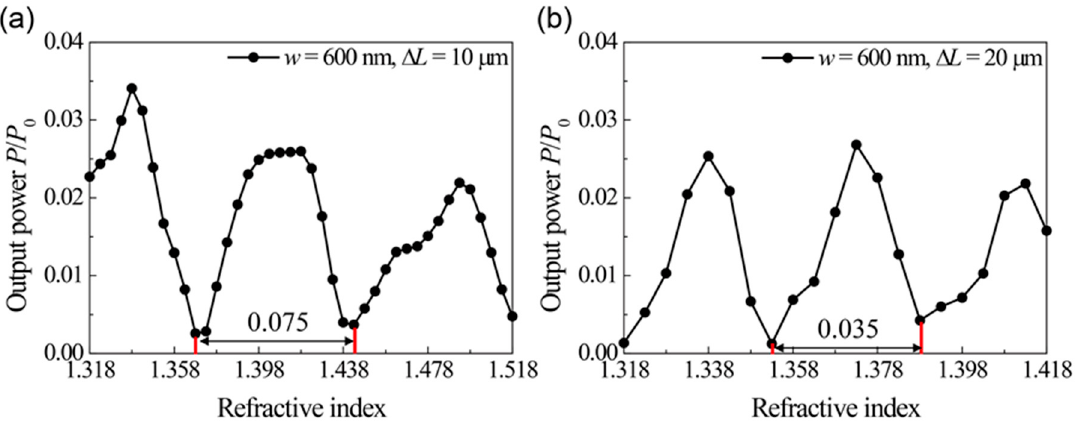
Figure 3. Cont. Figure 3.